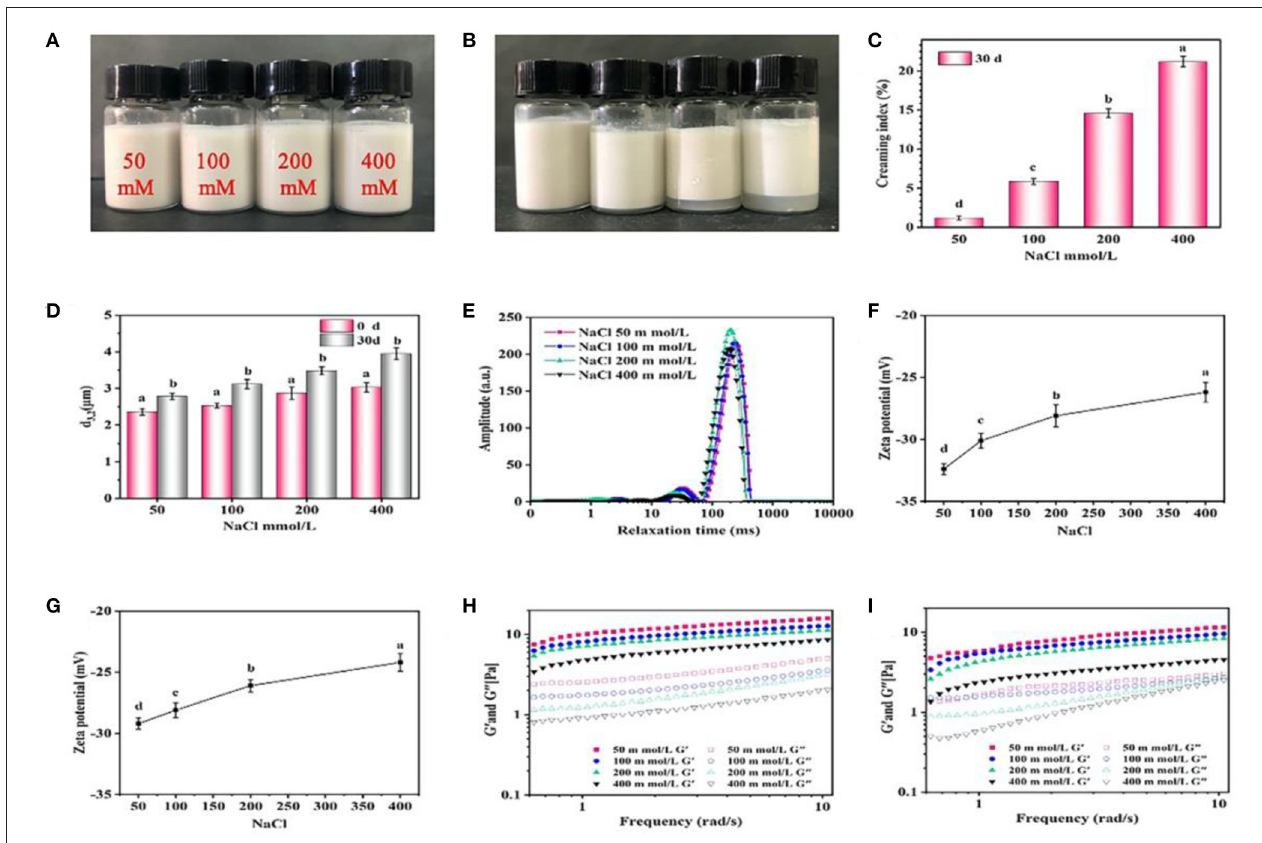
FIGURE 7 | Effects of NaCl concentration on the visual appearance (A,B) , creaming index (C) , droplet size (D) , LF-NMR (E) , ζ -potential (F,G) and rheological properties (H,I) of the emulsions prepared by 2% proteins and 3:7 oil/water ratio after 0 and 30 days storage. Mean values followed by different letters are significantly different ( P <